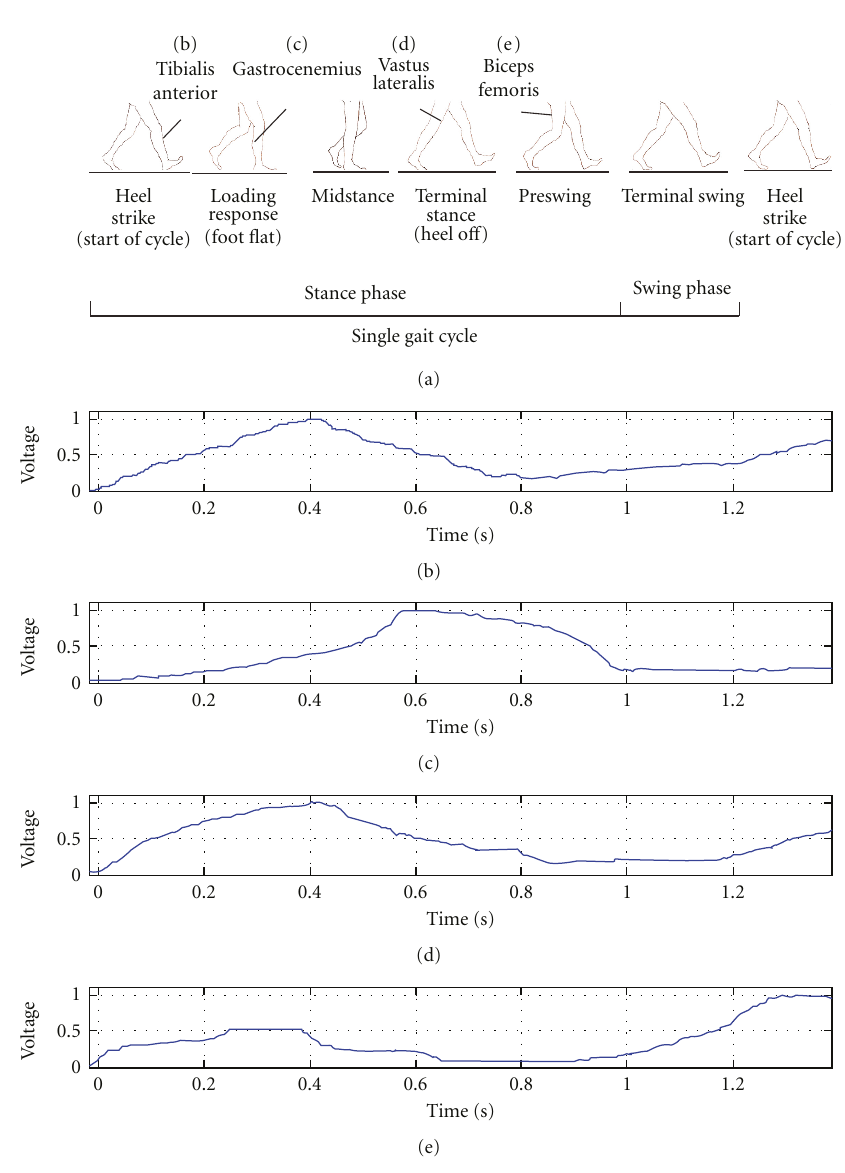
Figure 3: (a) Gait cycle aligned with normalized EMG voltages of (b) tibialis anterior, (c) gastrocnemius, (d) vastus lateralis, and (e) biceps femoris in a healthy case over a single gait